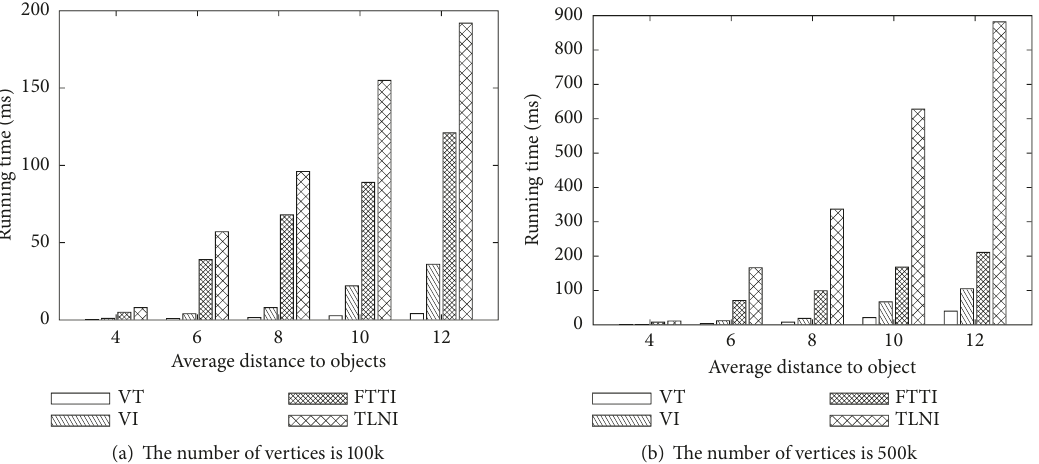
Figure 9: Impact of the average distance to objects.